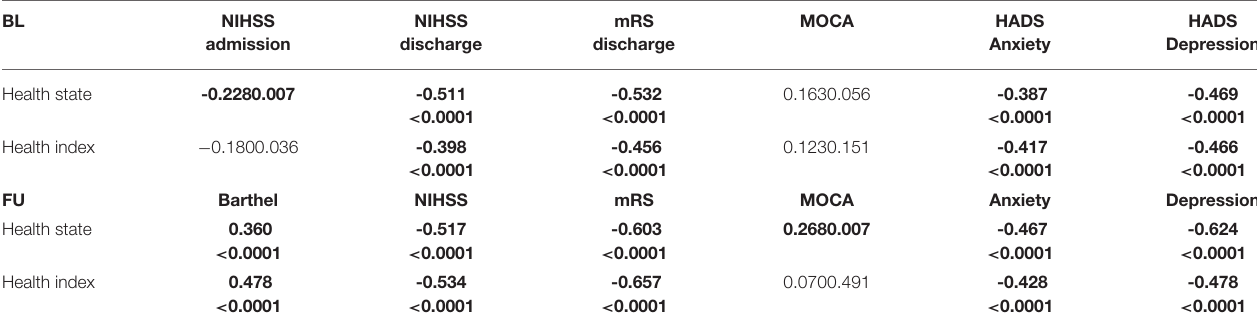
TABLE 2 | Correlations between health-state and health index and clinical, cognitive, and emotional scores at BL and at 3 months FU. BL NIHSS